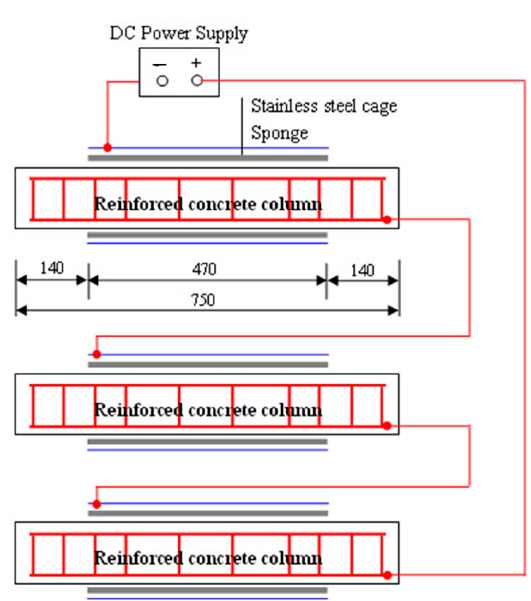
Figure 3. Schematic illustration of accelerated corrosion test setup.